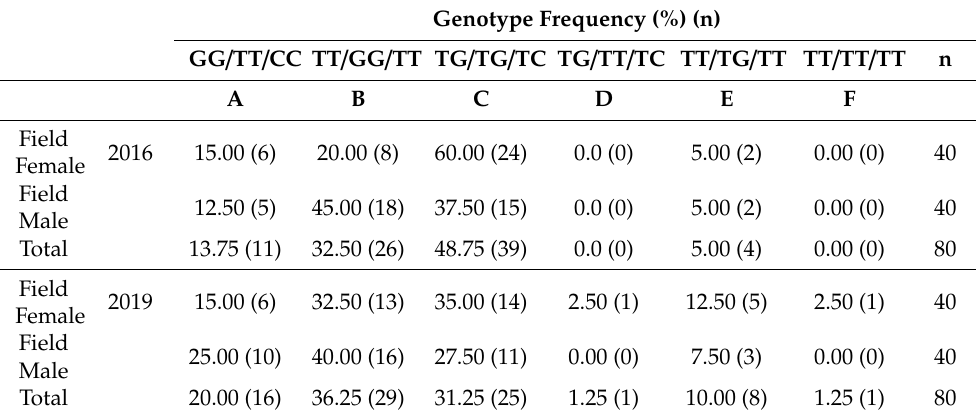
Table 6. Comparison of Vssc genotypes found in the field (PKNS Shah Alam) in 2016 (pre-release) and 2019 (post-release of Wolbachia ) in Ae . aegypti.